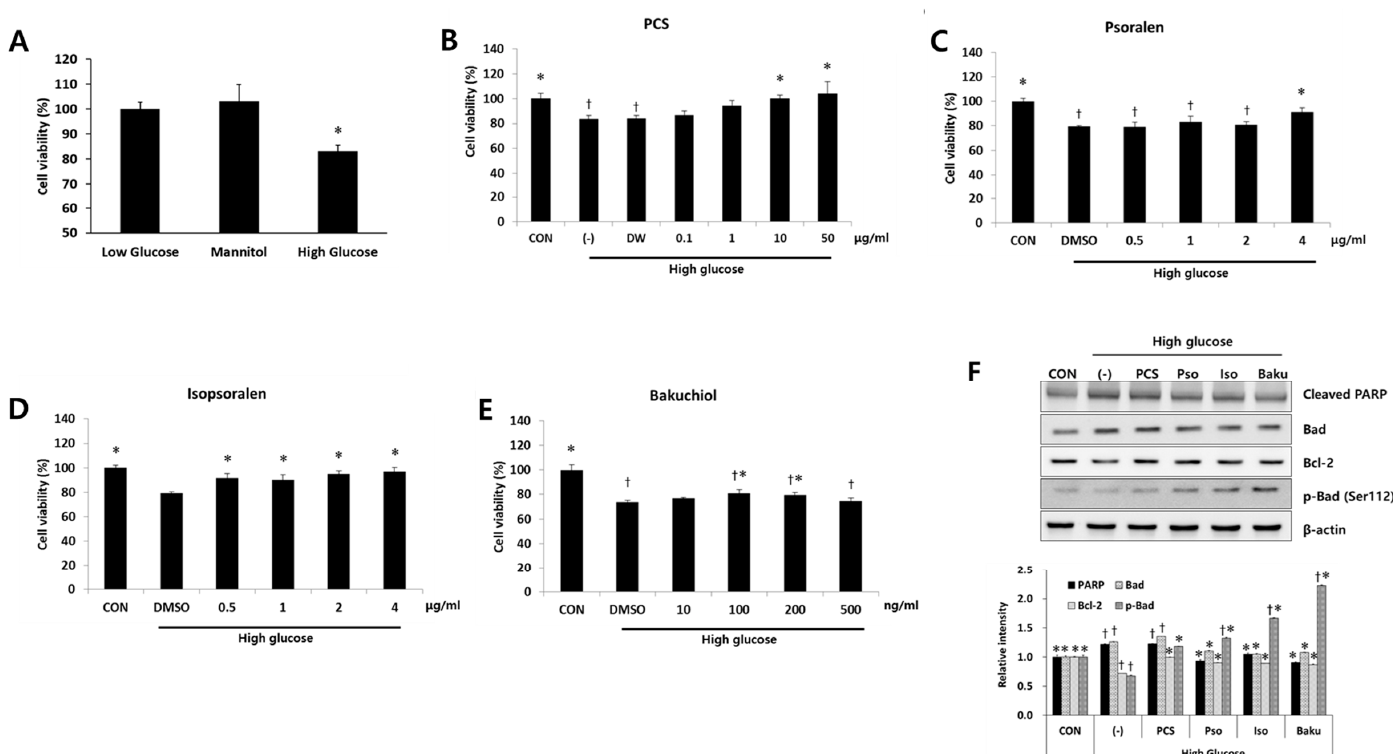
Figure 4. Effect of PCS extract and its components on viability and apoptosis in high glucose-treated mesangial cells. ( A ) SV40 MES13 cells were cultured with low glucose (5.5 mM), 5.5 mM glucose and 19.4 mM mannitol, or high glucose (25 mM) for 24 h and cell viability were determined by CCK-8 assay. *, p < 0.05 vs. Low glucose. SV40 MES-13 cells were treated with high glucose concentration (25 mM) with or without (-) various concentrations of PCS extract or its components for 24 h. Cells cultured in the presence of 5 mM glucose without any treatment were used as a control (CON). Cell viability after treatment with: ( B ) PCS extract; ( C ) Psoralen; ( D ) Isopsoralen; or ( E ) Bakuchiol were determined by CCK-8 assay. †, p < 0.05 vs. CON. *, p < 0.05 vs. (-)/High glucose. ( F ) Protein was prepared after treatment with PCS extract (50 μ g/mL), psoralen (4 μ g/mL), isopsoralen (4 μ g/mL), or bakuchiol (200 ng/mL), and western blotting analysis was carried out for cleaved PARP, Bad, Bcl-2, and p-Bad (Ser112). Actin was used as a loading control. Corresponding densitometric quantification of western blotting analysis is presented at the bottom. The results shown represent the mean ± SEM from three independent duplicate experiments. †, p < 0.05 vs. CON. *, p < 0.05 vs. (-)/High glucose.